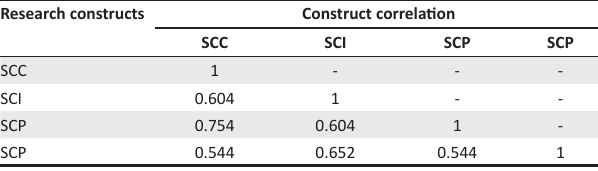
TABLE 2: Correlation between the constructs. Research constructs Construct